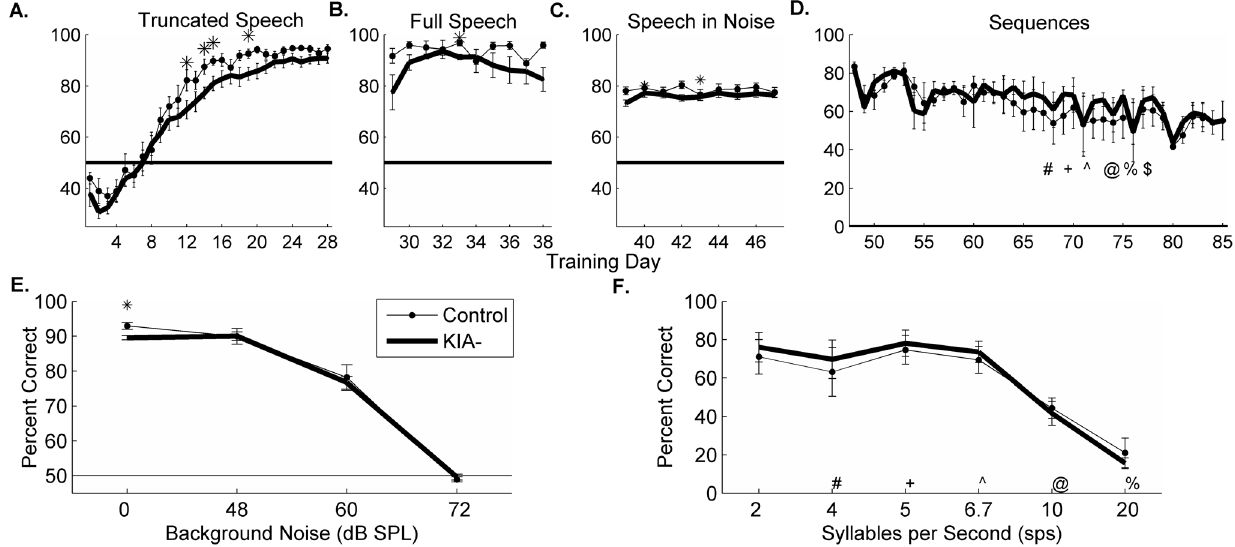
Figure 4. Extensive truncated speech training improves full speech and speech in noise performance in KIA- rats. Horizontal lines in each panel represent chance performance for that task. A . Timeline of group 2 rats’ performance on truncated speech task. KIA- rats needed slightly longer to reach 80% correct compared to controls (unpaired 1-tailed t-test, p=0.07). At the end of training, there was no significant difference in performance across groups (unpaired 1-tailed t-test, p=0.11). B . Timeline of performance on full length speech task. C . Timeline of performance on the speech in noise task. D . Timeline of performance on the sequence task. Performance on this task falls slightly over time due to the addition of increased repetition rates. E . Last day of speech in noise performance by control and KIA- rats. F . Last day of sequence